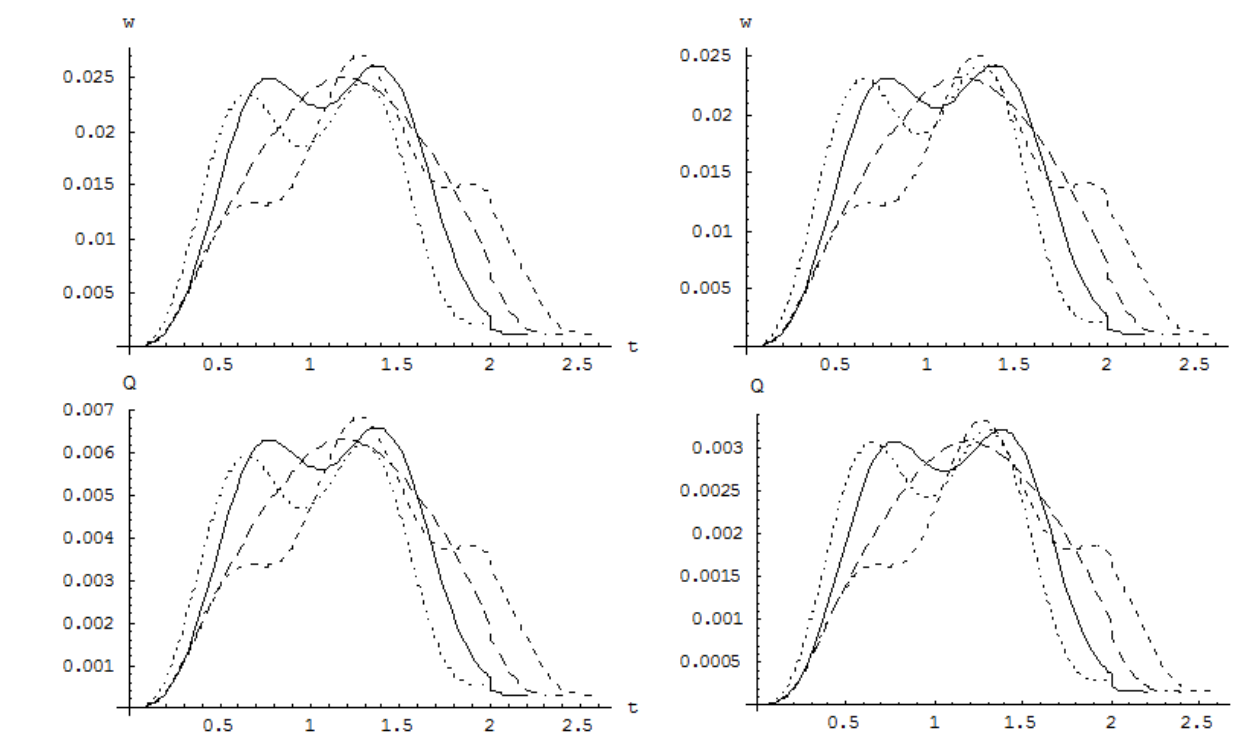
υ = 30 m/s, e H = 3.00 m, e V = 1.20 m and the above three models of loading.